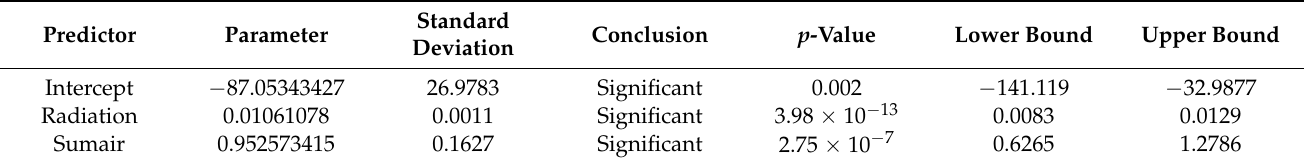
Table 3. Statistical characteristics of the model for surface temperature estimation.